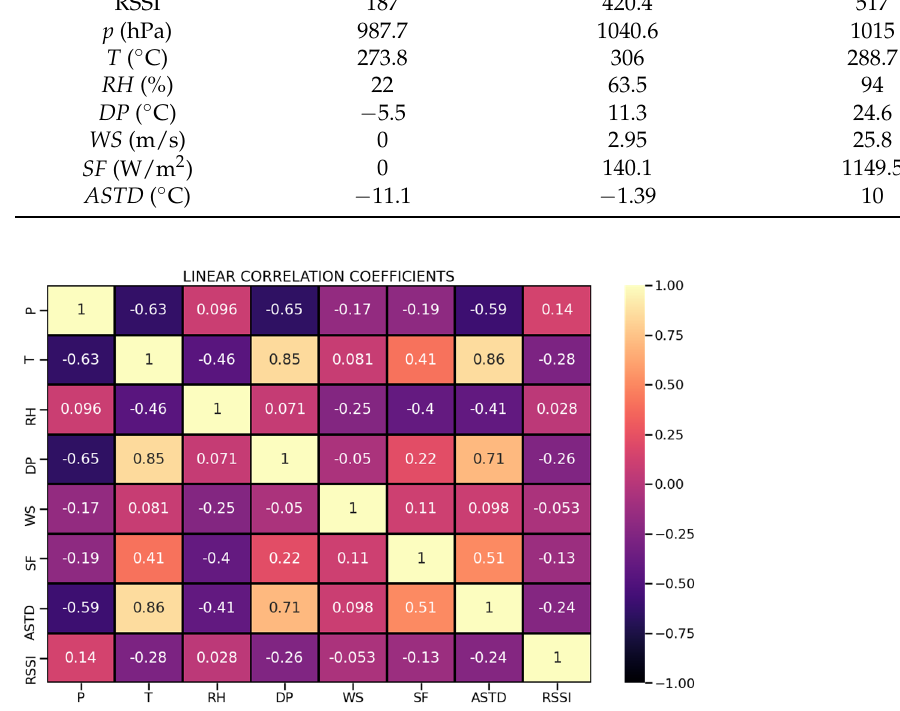
Figure 3. Matrix of linear correlation coefficients for measured meteorological parameters and RSSI.